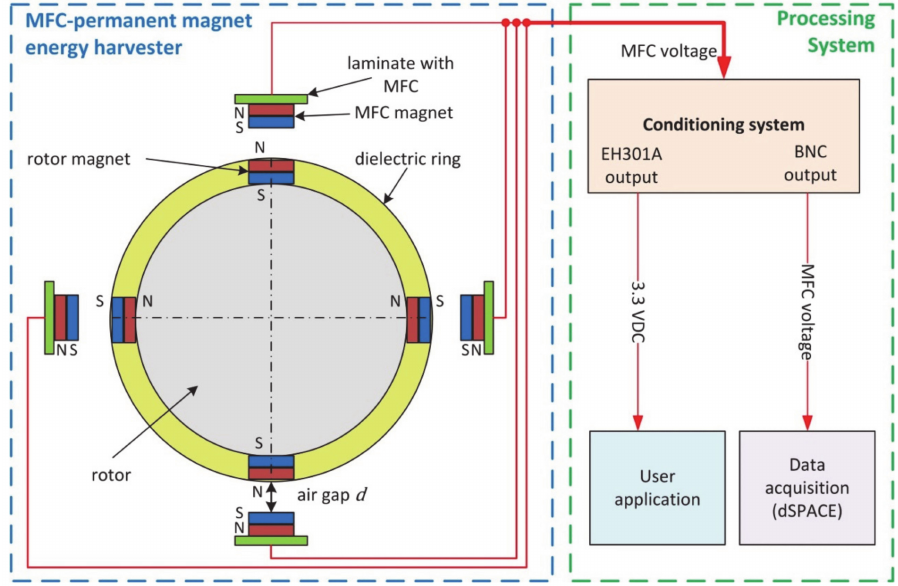
Figure 2. Configuration of the prototype